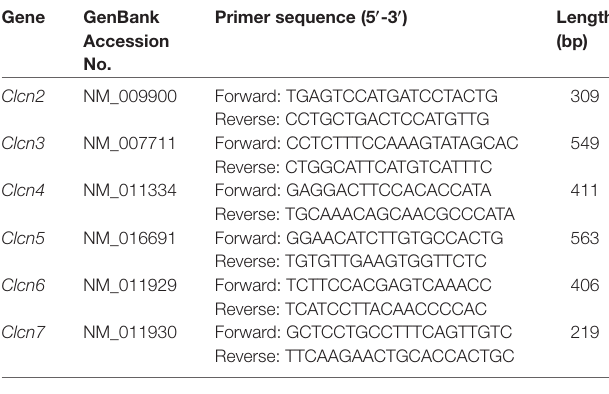
TABLE 1 | Primer pairs used for PCR amplifications.